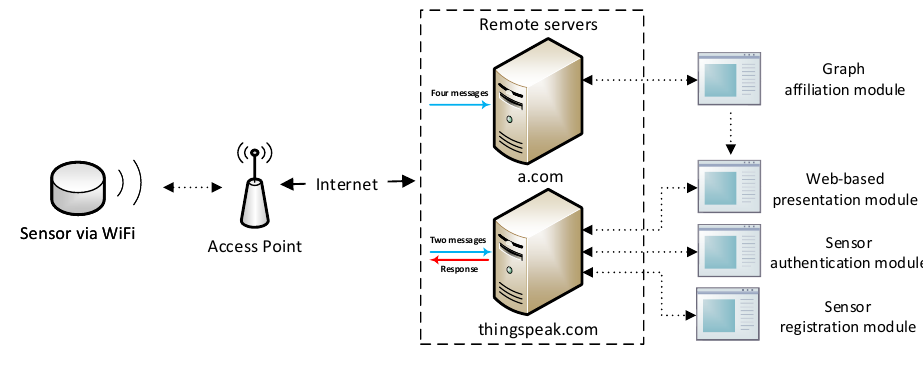
Figure 4. Discovered System